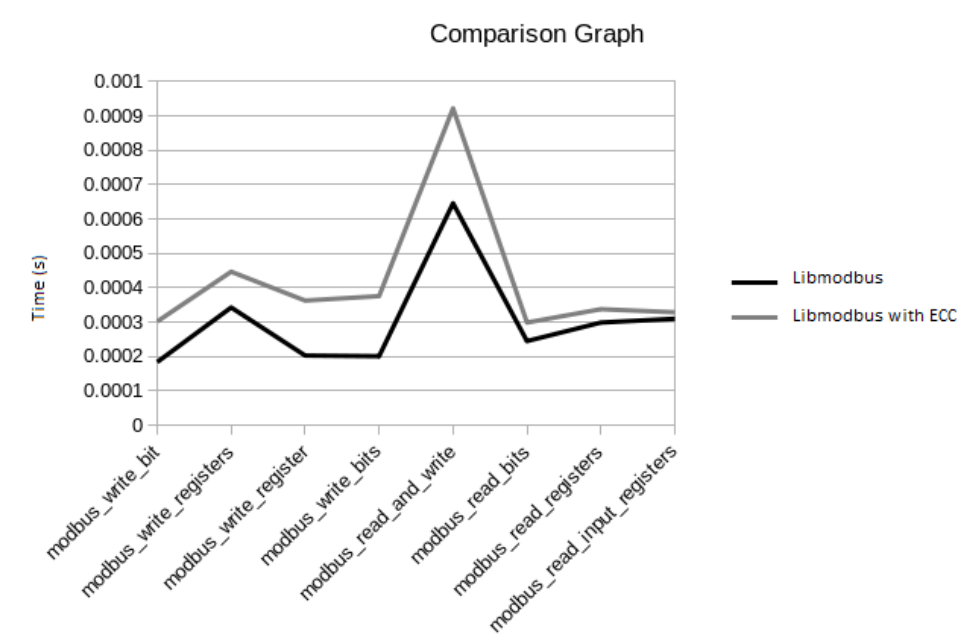
Figure 9. Comparison of Modbus and Modbus with encryption.